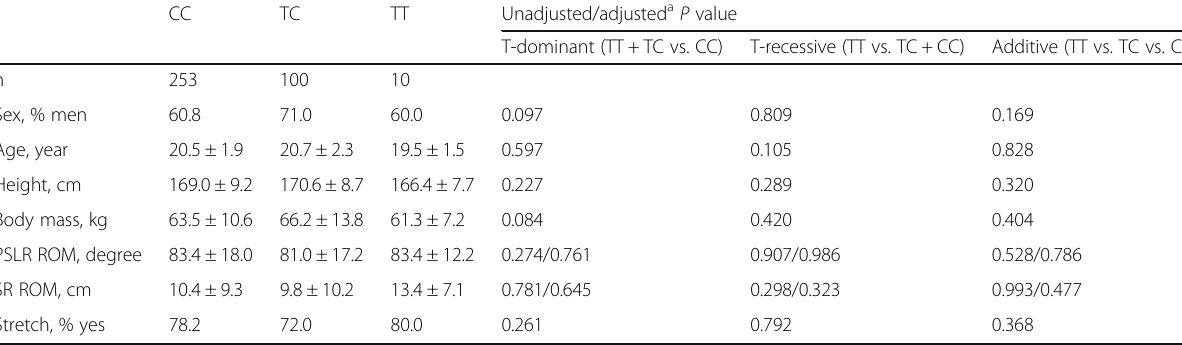
Table 2 Participant characteristics by COL5A1 genotype in Study 1 ( n = 363)